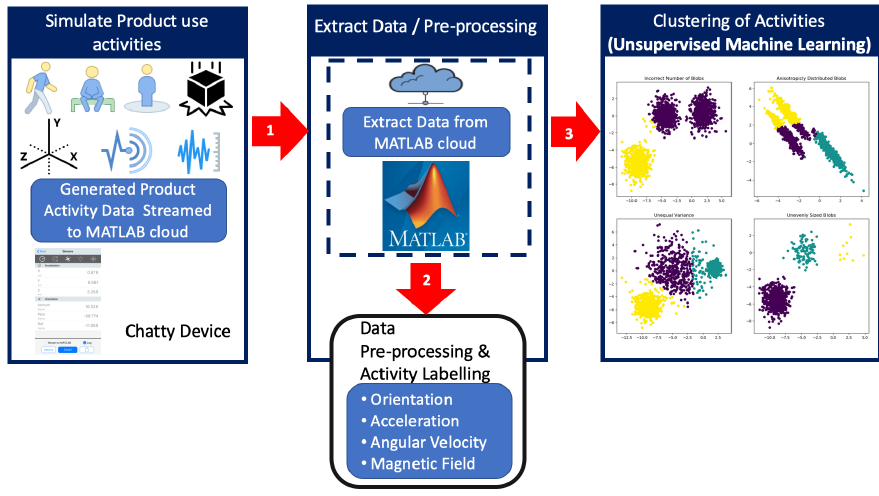
Figure 2. Flow of